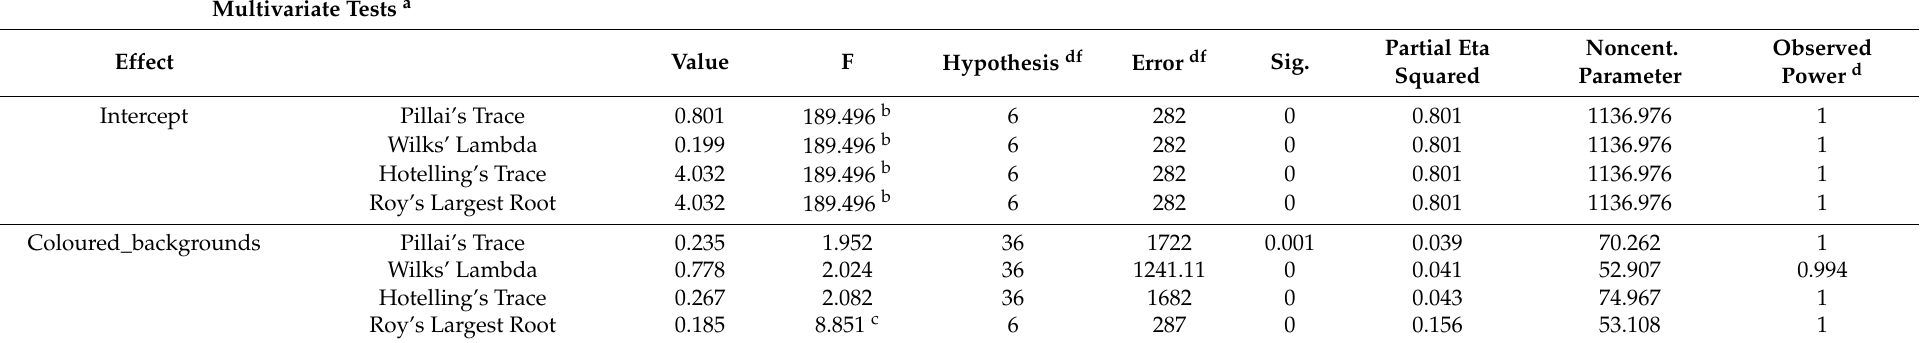
Table A7. Multivariate Tests of People’s Logical, Lateral, and Detail Abilities Affected by Colours. Multivariate Tests a